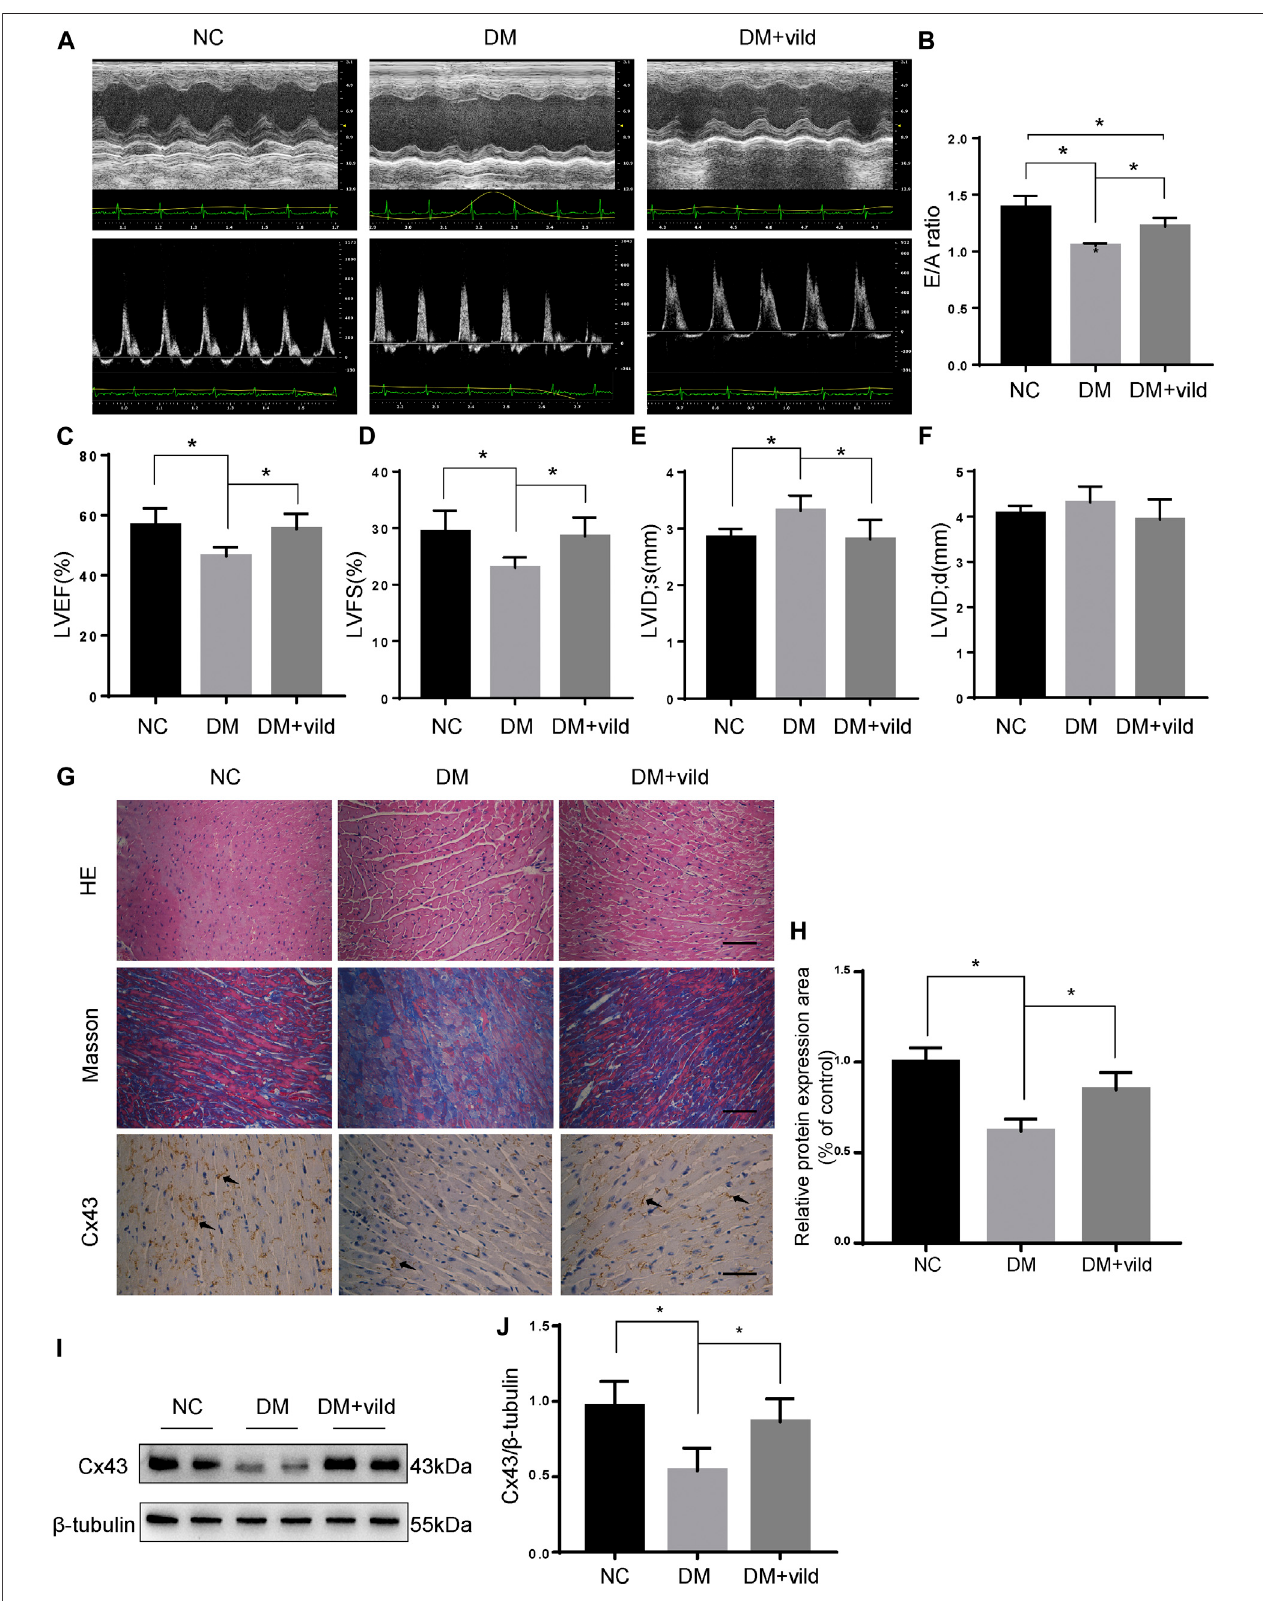
FIGURE 1 | Vild protects heart function and alleviates hyperglycemia-induced pathological changes. (A) M-mode echocardiograms and pulse-wave Doppler